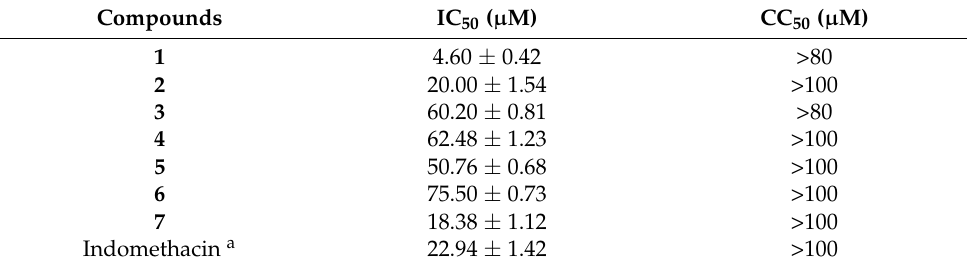
Table 4. The inhibitory effects of compounds 1 – 7 on NO production in LPS-stimulated RAW264.7.